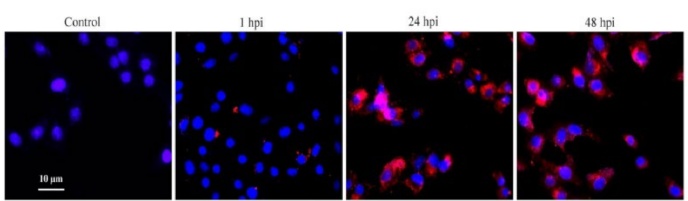
Figure 1. PCV2 infection in PAMs. PCV2 in PAMs post-infection was detected by IFA based on the ODs-psdAb probe (red), the nucleus was stained with DAPI